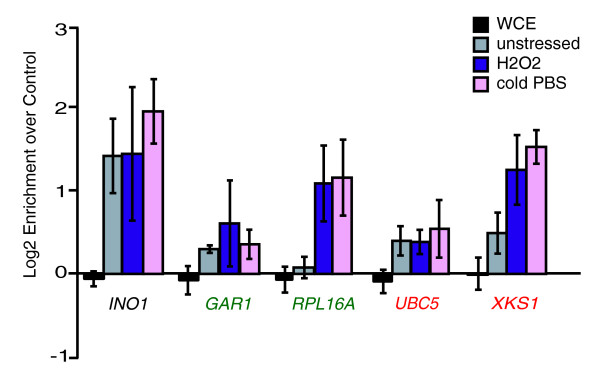
Rpd3p is bound upstream of several target genes after stress. Rpd3-myc binding upstream of several genes (including the positive control INO1, PS gene GAR1, RP gene RPL16A, and iESR genes UBC5 and XKS1) was assessed using ChIP before and 10 minutes after 0.4 mM H2O2 treatment or cold phosphate-buffered saline shock (see Materials and methods for details). The log2 enrichment of each fragment recovered from the Rpd3-myc expressing strain versus an untagged control strain is shown, for unstressed cells and cells responding to stress, according to the key on the right. Error bars represent the standard deviation of biological triplicates. The enrichment of each locus in whole-cell extracts (WCE) is shown as a control.